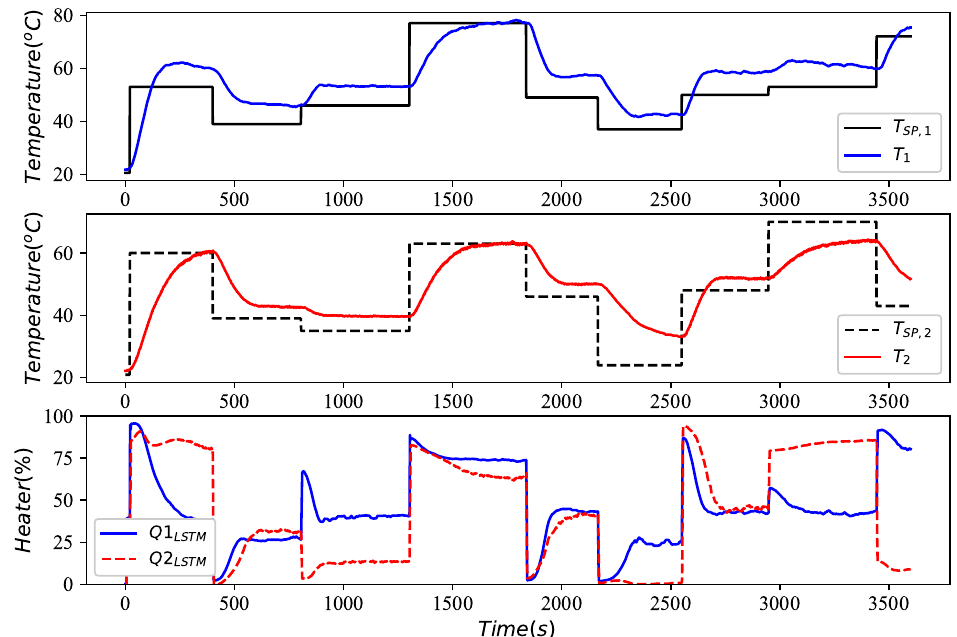
Figure 9. Scenario 3. Temperature and heater output of an approximate MPC control deployed online to a small scale temperature control (target system). The approximate MPC control is trained using 50,000 points of source data and fine tuned with 600 points of target